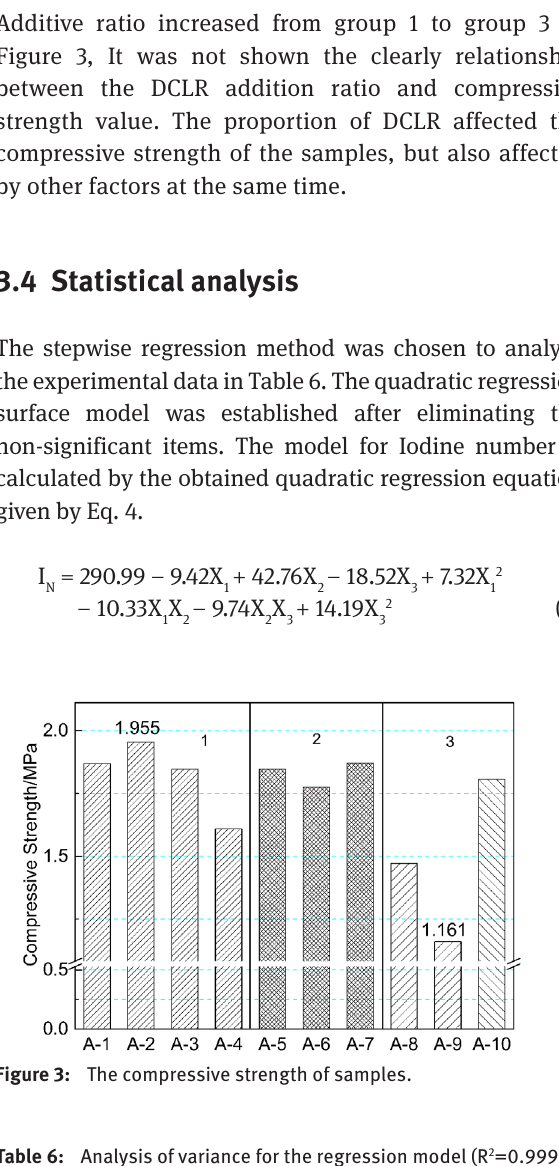
Table 6: Analysis of variance for the regression model (R 2 =0.9997).